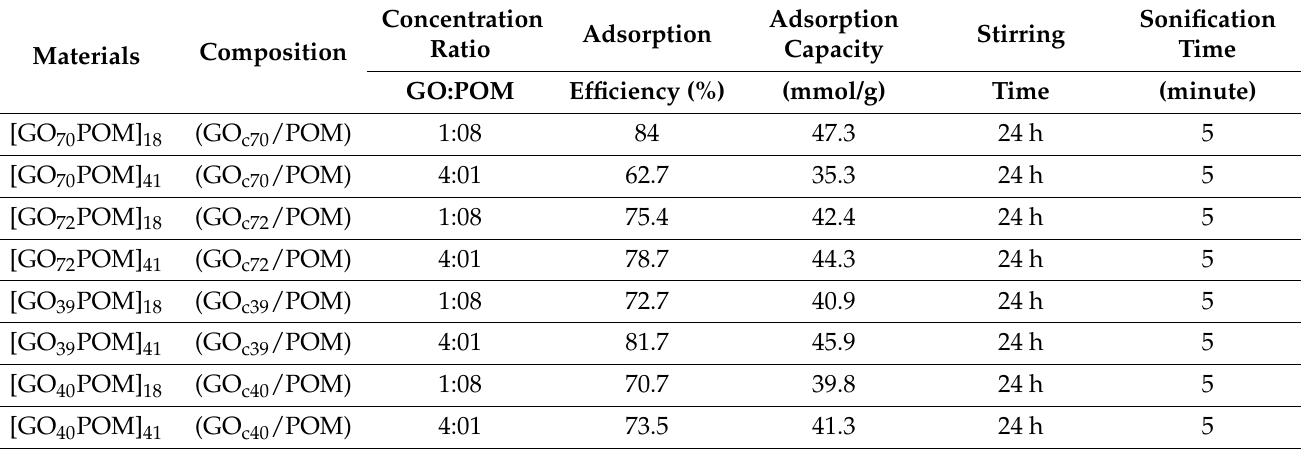
Table 3. Adsorption capacity, adsorption efficiency, and adsorption